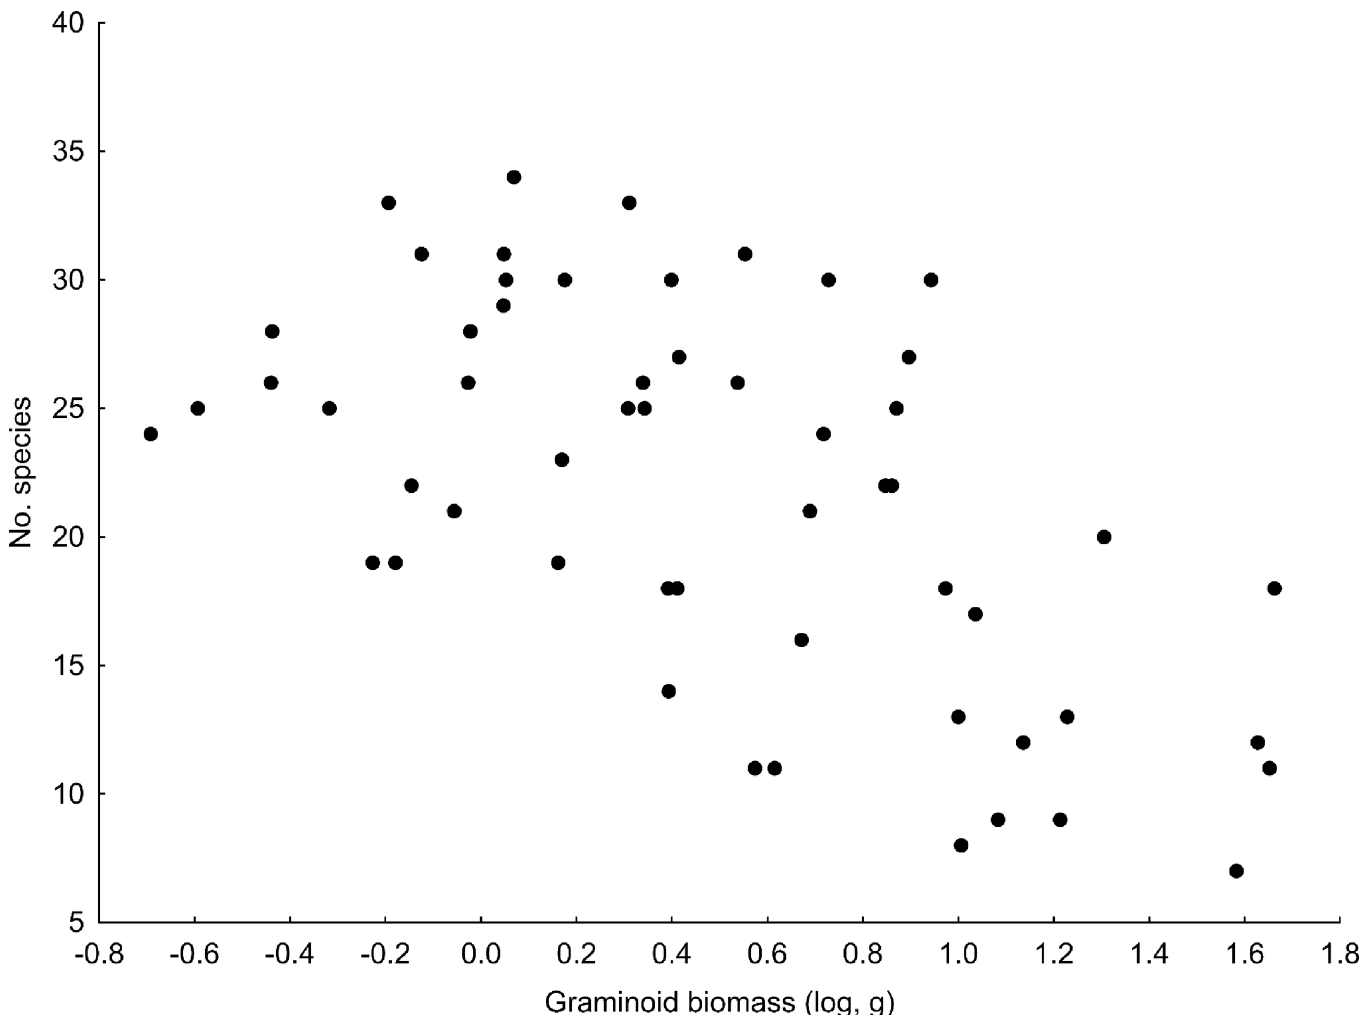
Fig 2. The relationship between the numbers of species in the microcosms and the biomass of the